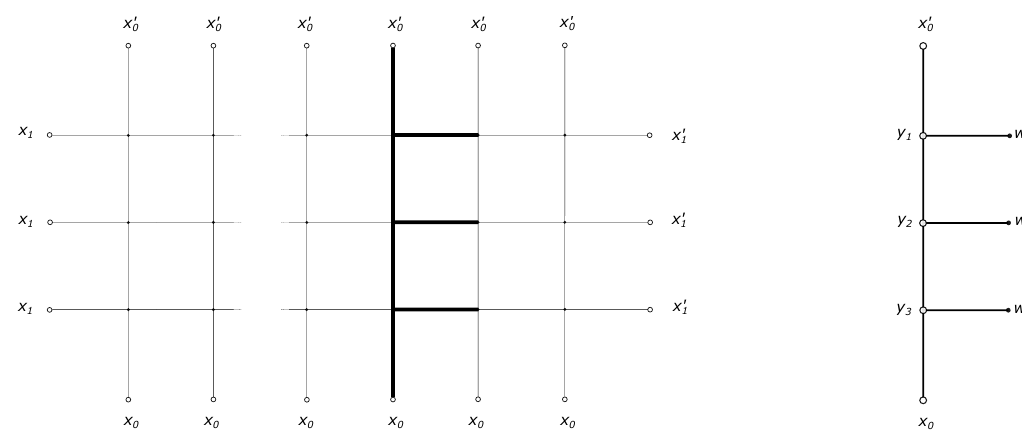
Figure 2 . On the left, we highlight a transfer matrix inside the square-lattice of the fishnet integral (1.1). On the right, we represent it separately, as the kernel of an integral operator, where the black dots are the integration point, according to formula (1.9). The transfer matrix makes a function propagate throughout the bulk of the diagram, from right to